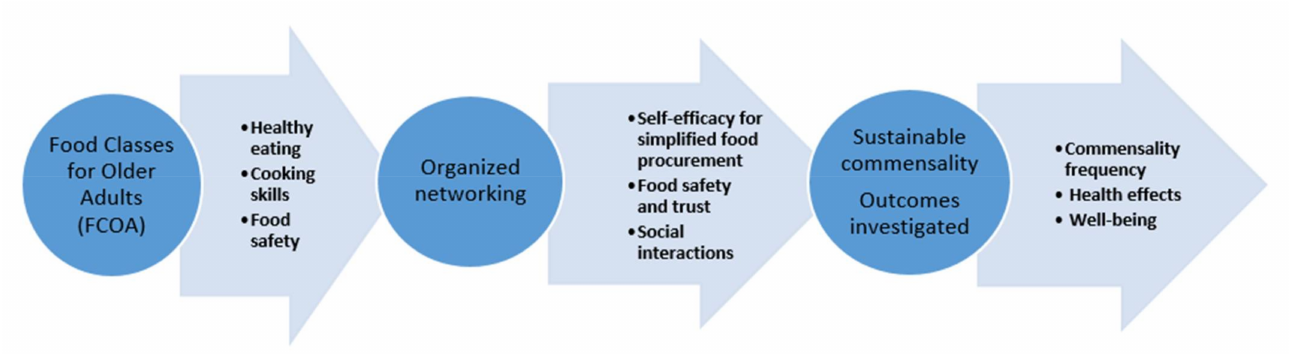
Figure 1. A theoretical model for sustainable commensality among older adults. An organized network is initiated by the practitioners at the Food Classes for Older Adults (FCOA), to be continued also after the